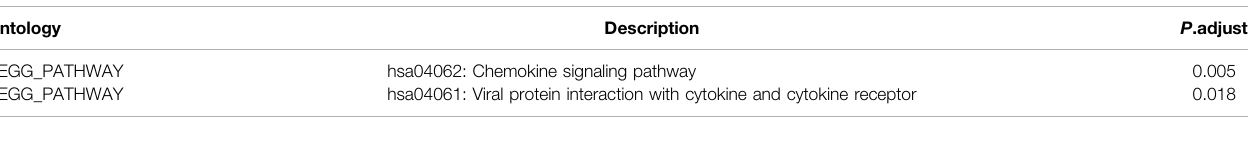
TABLE 3 | KEGG pathway enrichment of IRDEGs.